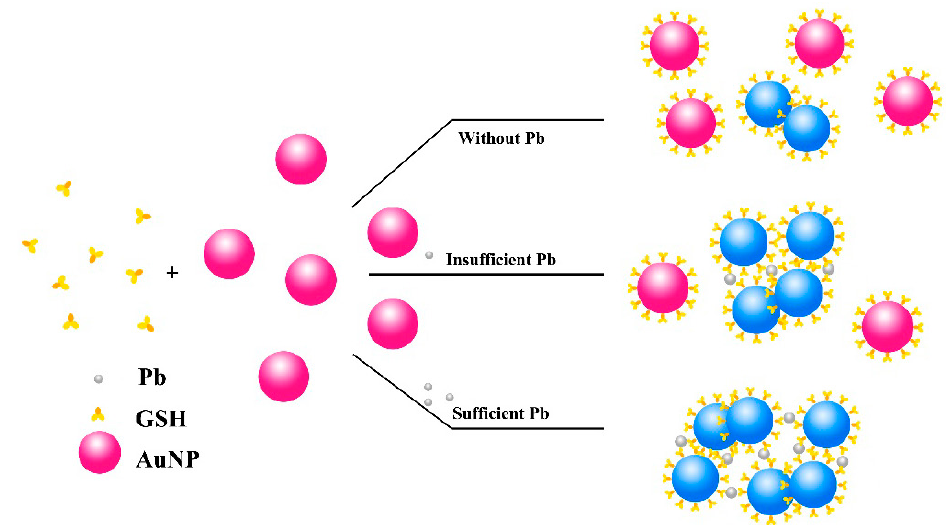
Figure 1. Schematic principle of the time-dependent determination of Pb II concentrations in water. The aggregation rate of AuNPs varies according to concentrations of Pb II